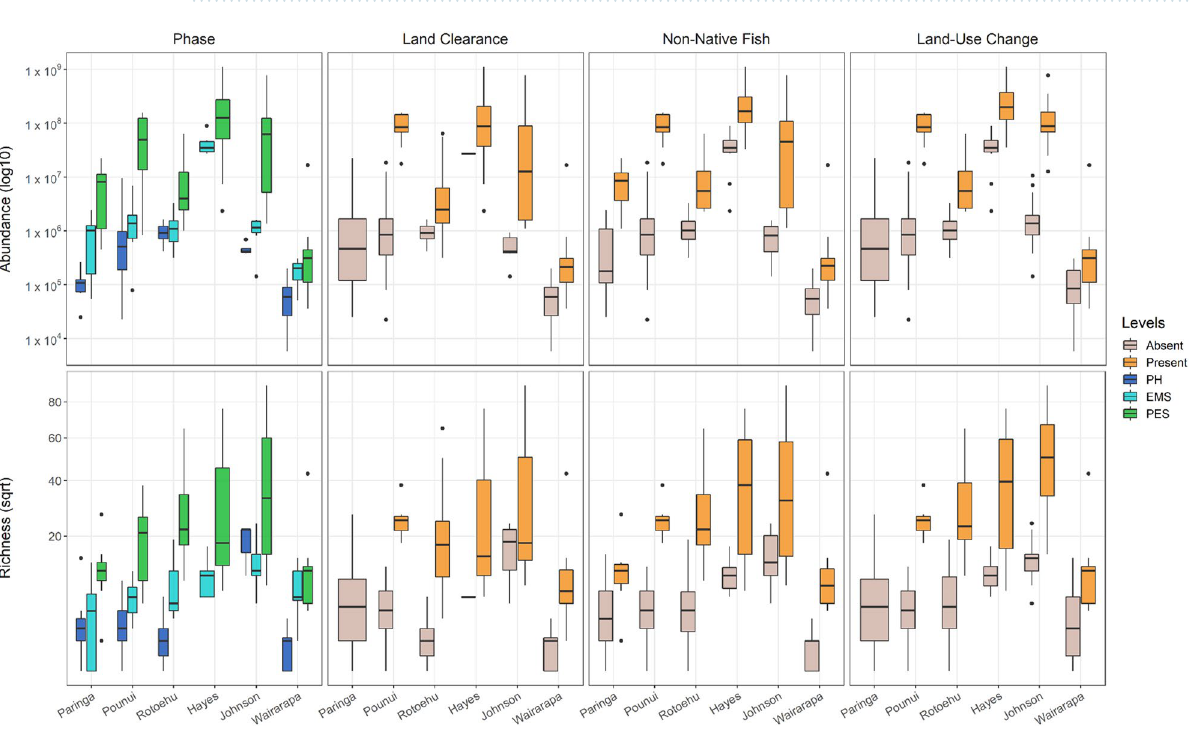
Figure 4. Differences in each response (cyanobacteria abundance or richness) depending on the lake and predictor variable. Cyanobacteria abundance was measured by droplet digital PCR (ddPCR–16S rRNA gene copy numbers/gram of dry sediment, log10 y-axis scale) while cyanobacteria richness was calculated from metabarcoding data (number of photosynthetic cyanobacteria Amplicon Sequence Variants per sample, square- root y-axis scale). PH = Pre-Human, EMS = Evidence of Māori Settlement, PES = Post European